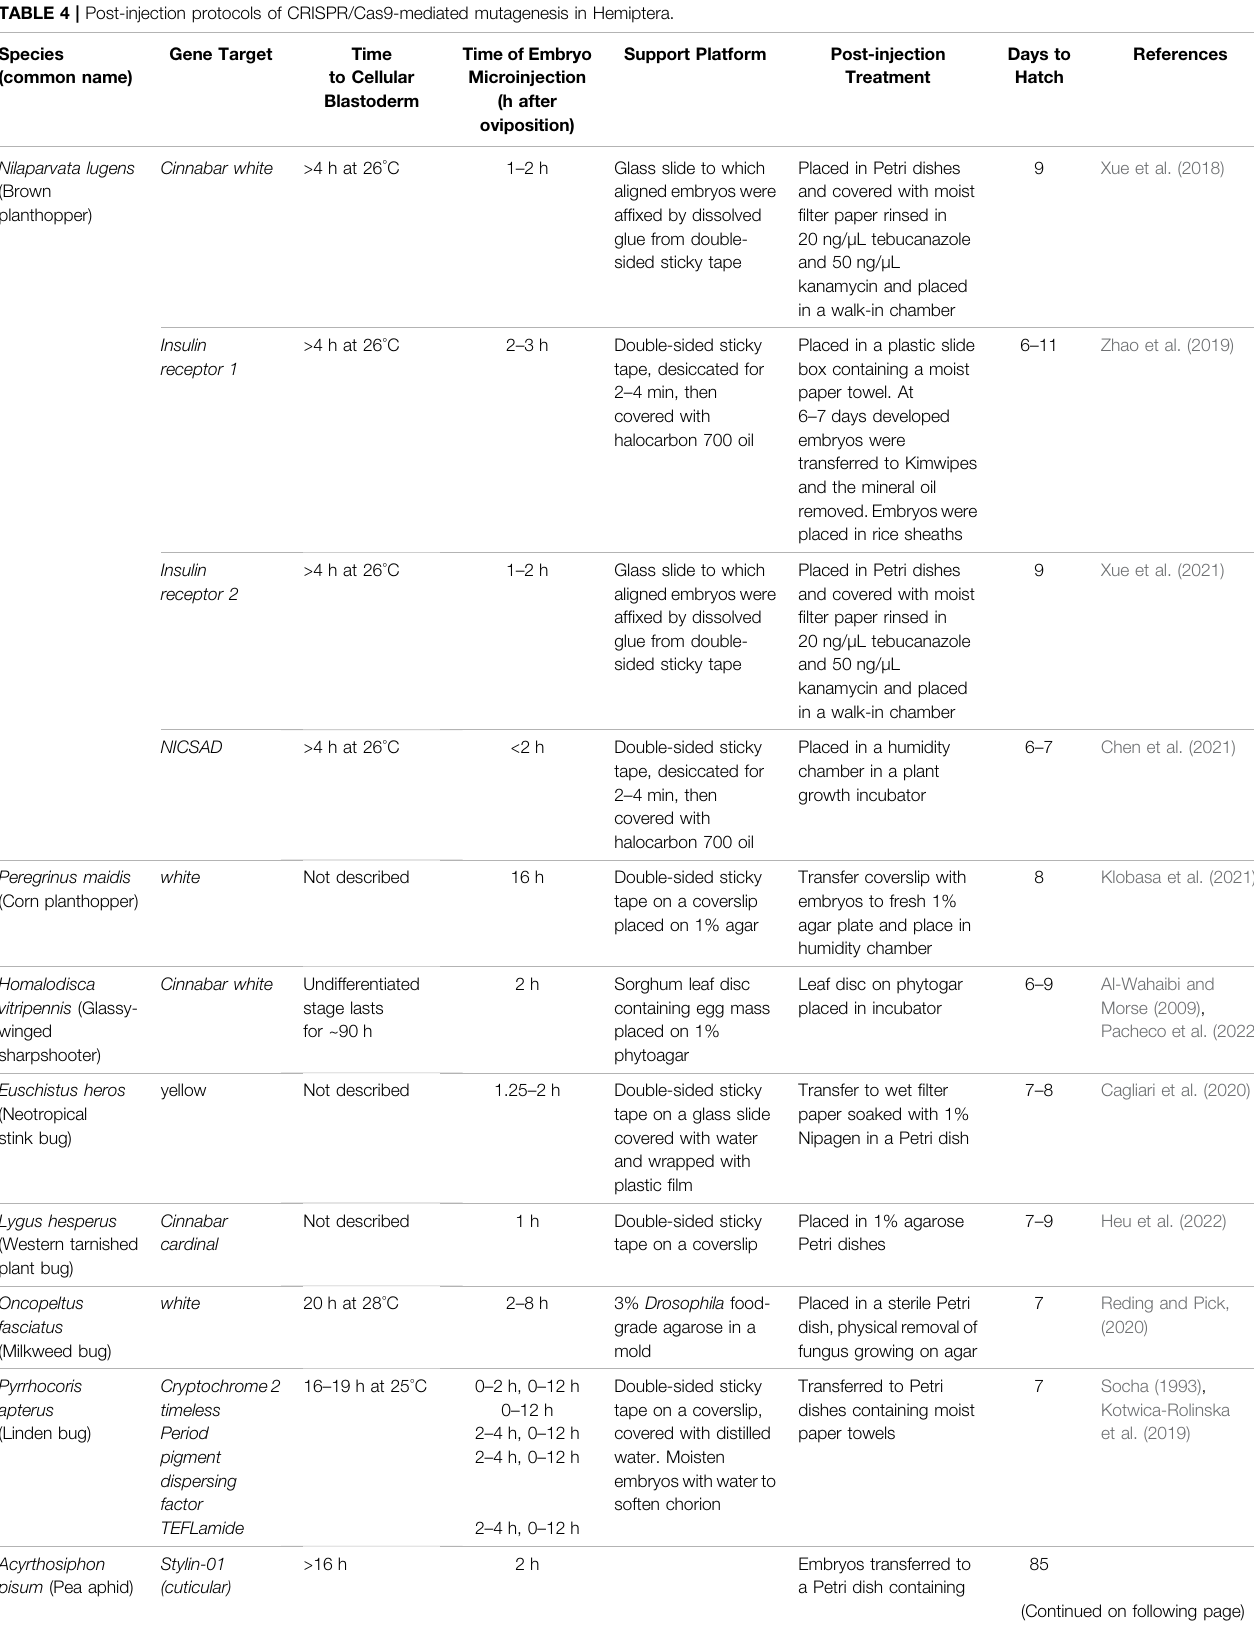
TABLE 4 | Post-injection protocols of CRISPR/Cas9-mediated mutagenesis in